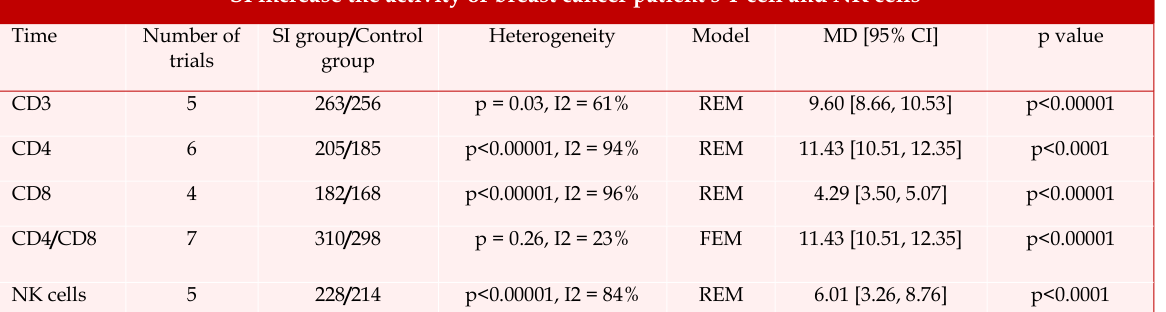
SI increase the activity of breast cancer patient's T cell and NK